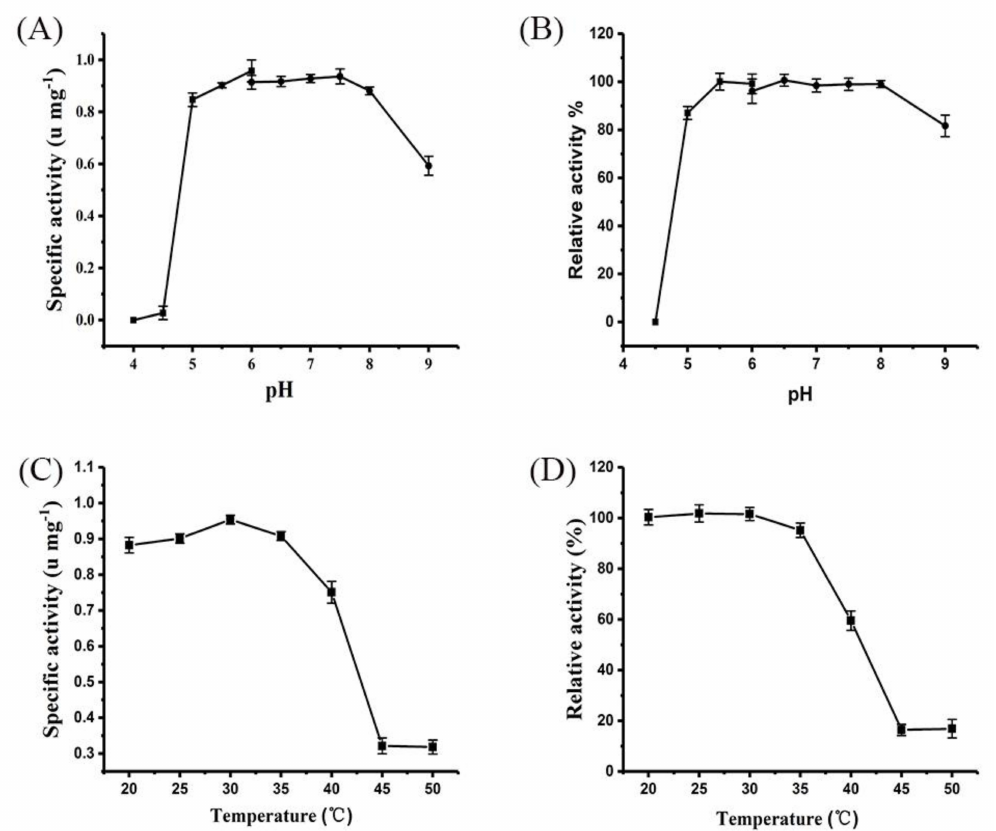
Figure 2. Effects of pH and temperature on purified XcAS transglucoside activity and stability. ( A ) Specific activity of XcAS at different external pH. Assays were performed at 30 ◦ C in 50 mM citrate buffer (pH 4.0–6.0) and 50 mM sodium phosphate buffer (pH 6.0–9.0). ( B ) pH stability of XcAS. Purified XcAS was preincubated at pH varying from 4.5 to 9.0 for 24 h at 4 ◦ C before enzyme activity was measured. ( C ) Specific activity of XcAS at different temperatures. Tests were performed at pH 7.0 in 50 mM sodium phosphate buffer. ( D ) Enzyme stability of XcAS at different temperatures. Assays were performed after preincubating XcAS for 1 h at different temperatures.